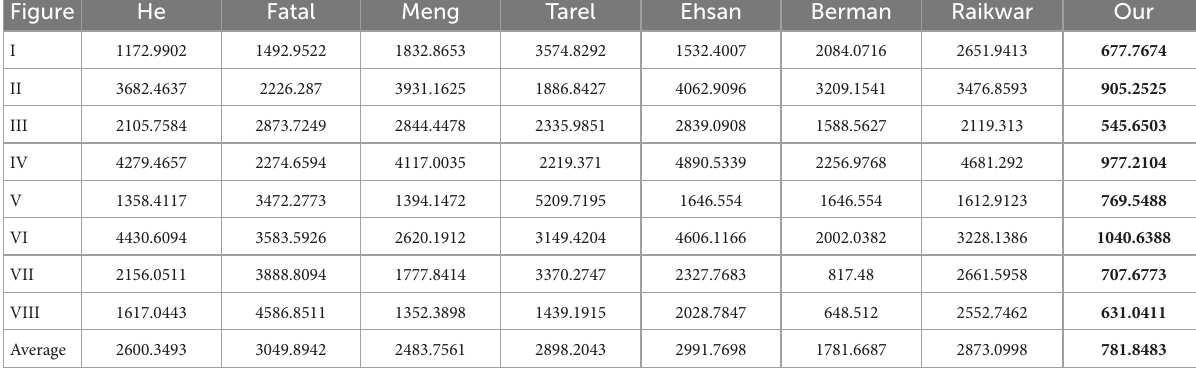
TABLE 4 Comparison of mean squared error (MSE) of the defogging images. Figure